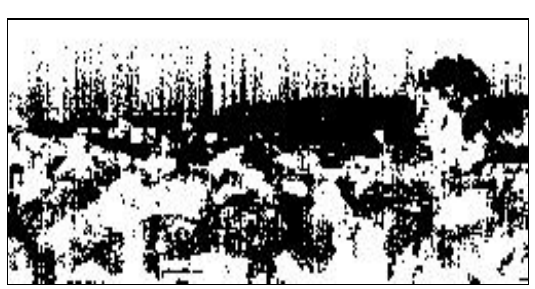
Fig.8: The performance of PPI and selected pixels as purest pixels versus iteration.